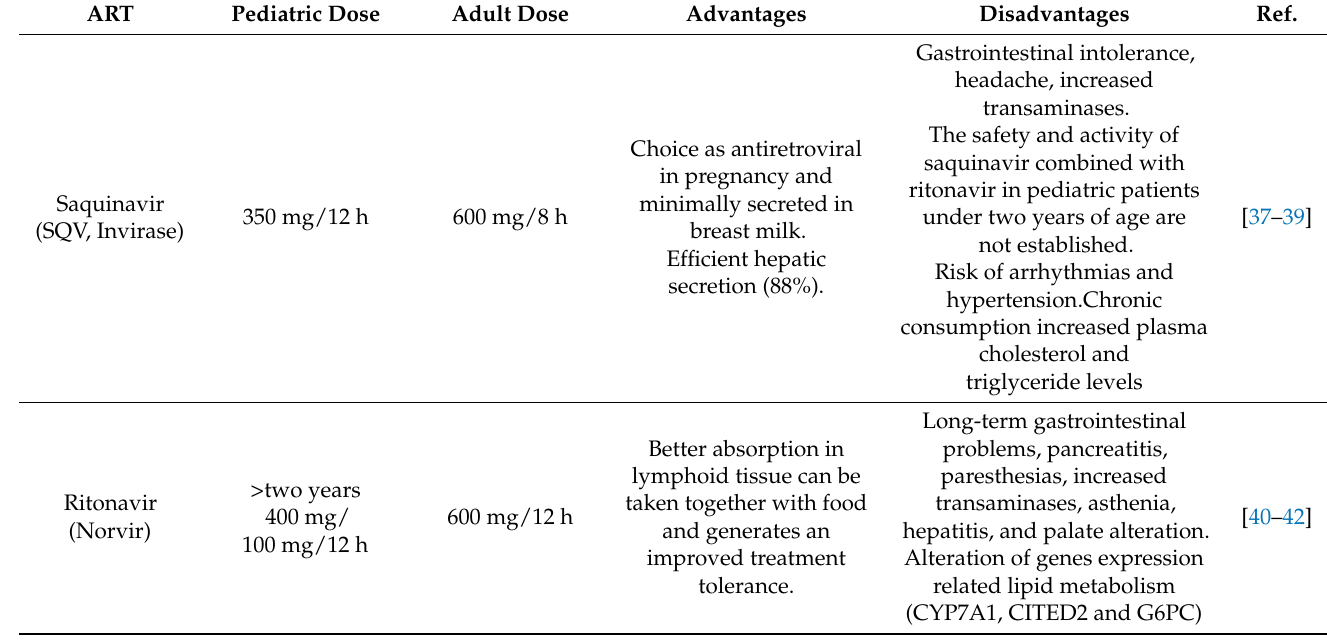
Table 1. Protease Inhibitors used as antiretroviral in children and